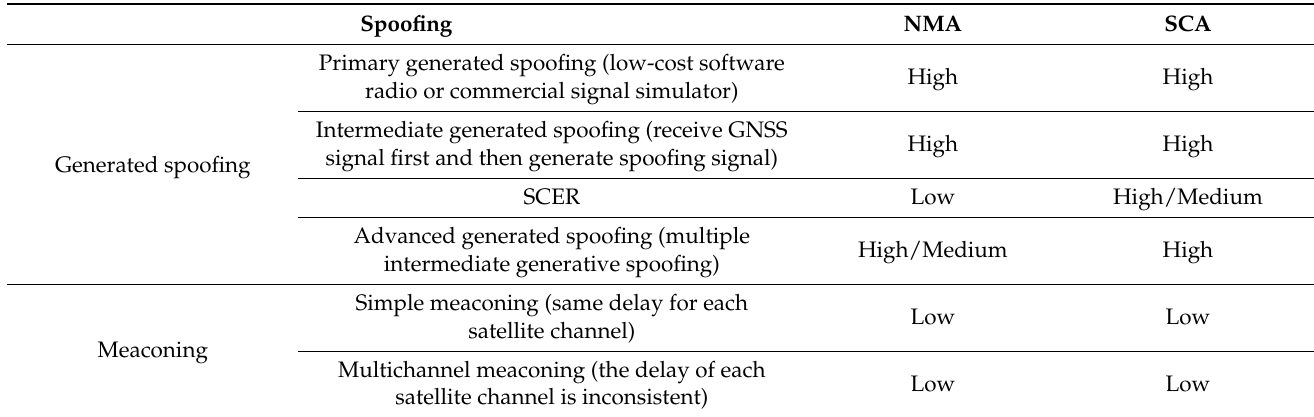
Table 4. Signal authentication anti-spoofing effect